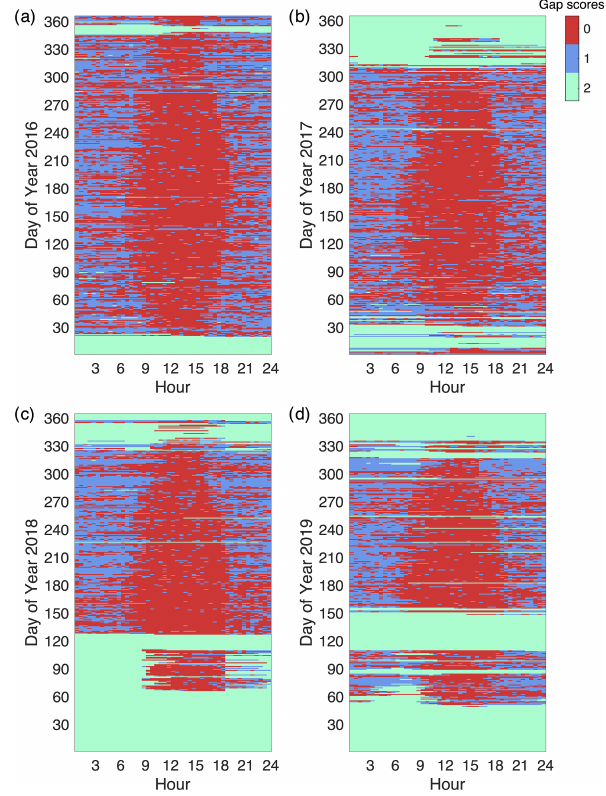
Figure 2. Distribution of NEE data gaps by day and hour from 2016 to 2019. NEE data gaps were classified as non-gaps (gap score: 0), gaps due to low data quality (gap score: 1), and gaps due to electrical and/or instrument failures (gap score: